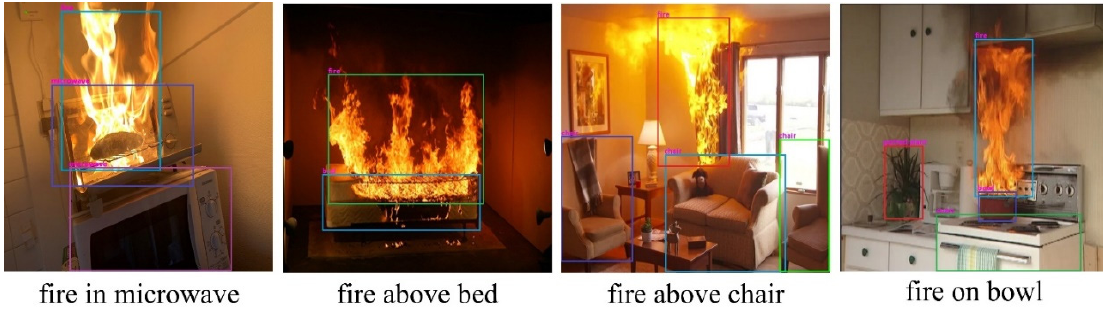
Figure 11. Example results of object mapping for image annotation.